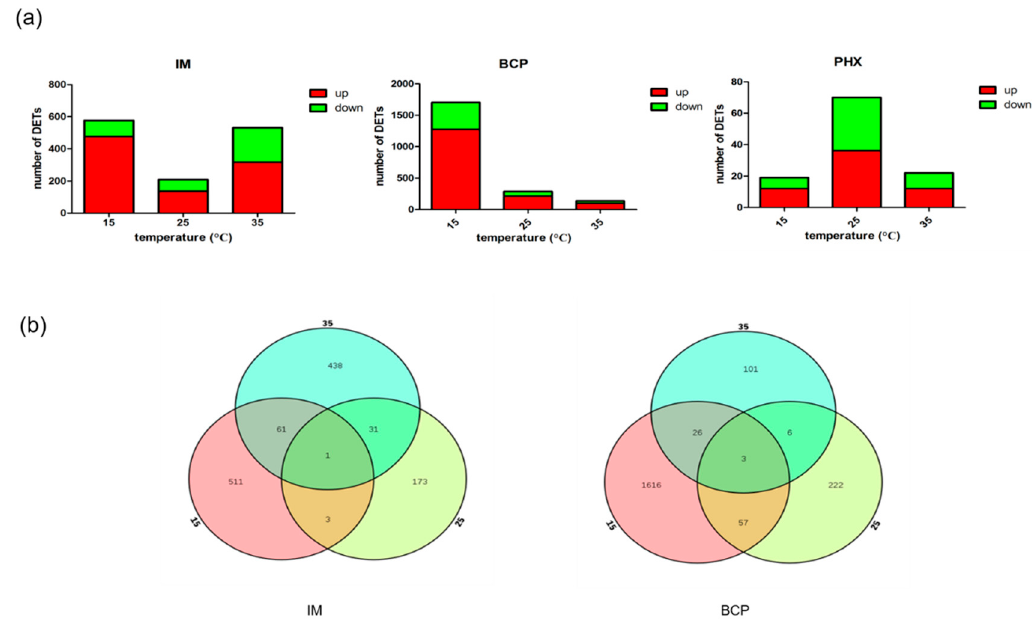
Figure 3. Statistics of differentially expressed transcripts by three insecticides treatments at different temperatures. ( a ) Number of individual transcripts significantly up- or down-regulated with different treatments. ( b ) Venn diagrams illustrating the number of transcripts by insecticides treatment at different temperatures.